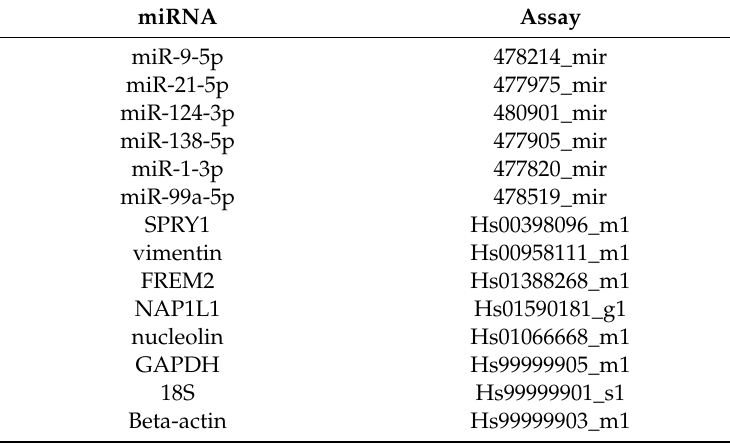
Table 7. List of the TaqMan probes used in the experiments. All the probes are from ThermoFisher. miRNA Assay miR-9-5p